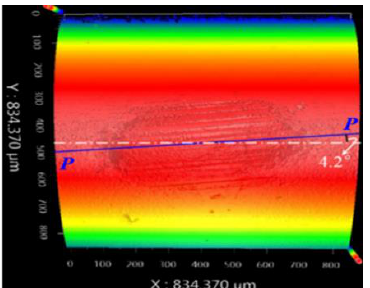
( d ) ( e ) Figure 2. Hysteresis loops of torque versus torsion angle during tension–torsion cyclic loading of steel wires with fretting contact in different environmental media. ( a ) Air. ( b ) Acid solution. ( c ) Neutral solution. ( d ) Alkaline solution. ( e ) Deionized water. 3.1.3. Wear Coefficient Figure 3 shows the irregularly elliptical front profile of wear scar of cyclic loaded wire in the